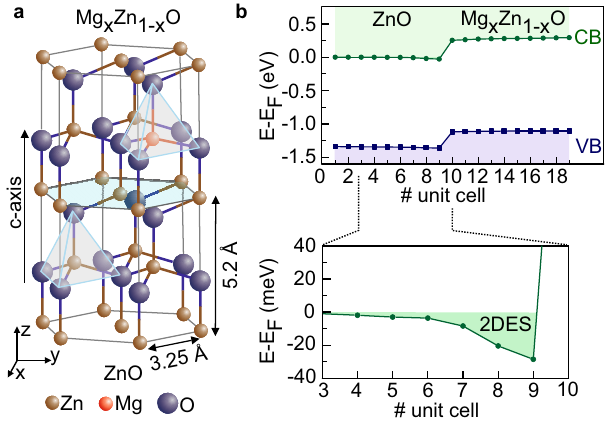
Fig. 1 Electronic structure of Mg x Zn 1 − x O/ZnO interface. a Schematic view of high mobility MgZnO/ZnO heterostructure. Both wurtzite crystal structure of ZnO and Mg x Zn 1 − x O/ZnO interface breaks the inversion symmetry. b The interface band structure is calculated using self consistent Green function method for semi-in fi nite systems considering x = 5%, a typical Mg content in the heterostructures. The conduction band (CB) of ZnO lowers at the interface forming the con fi nement potential for high mobility electrons. The size of the band gap in ZnO and Mg x Zn 1 − x O is underestimated due to the lack of the conventional density functional